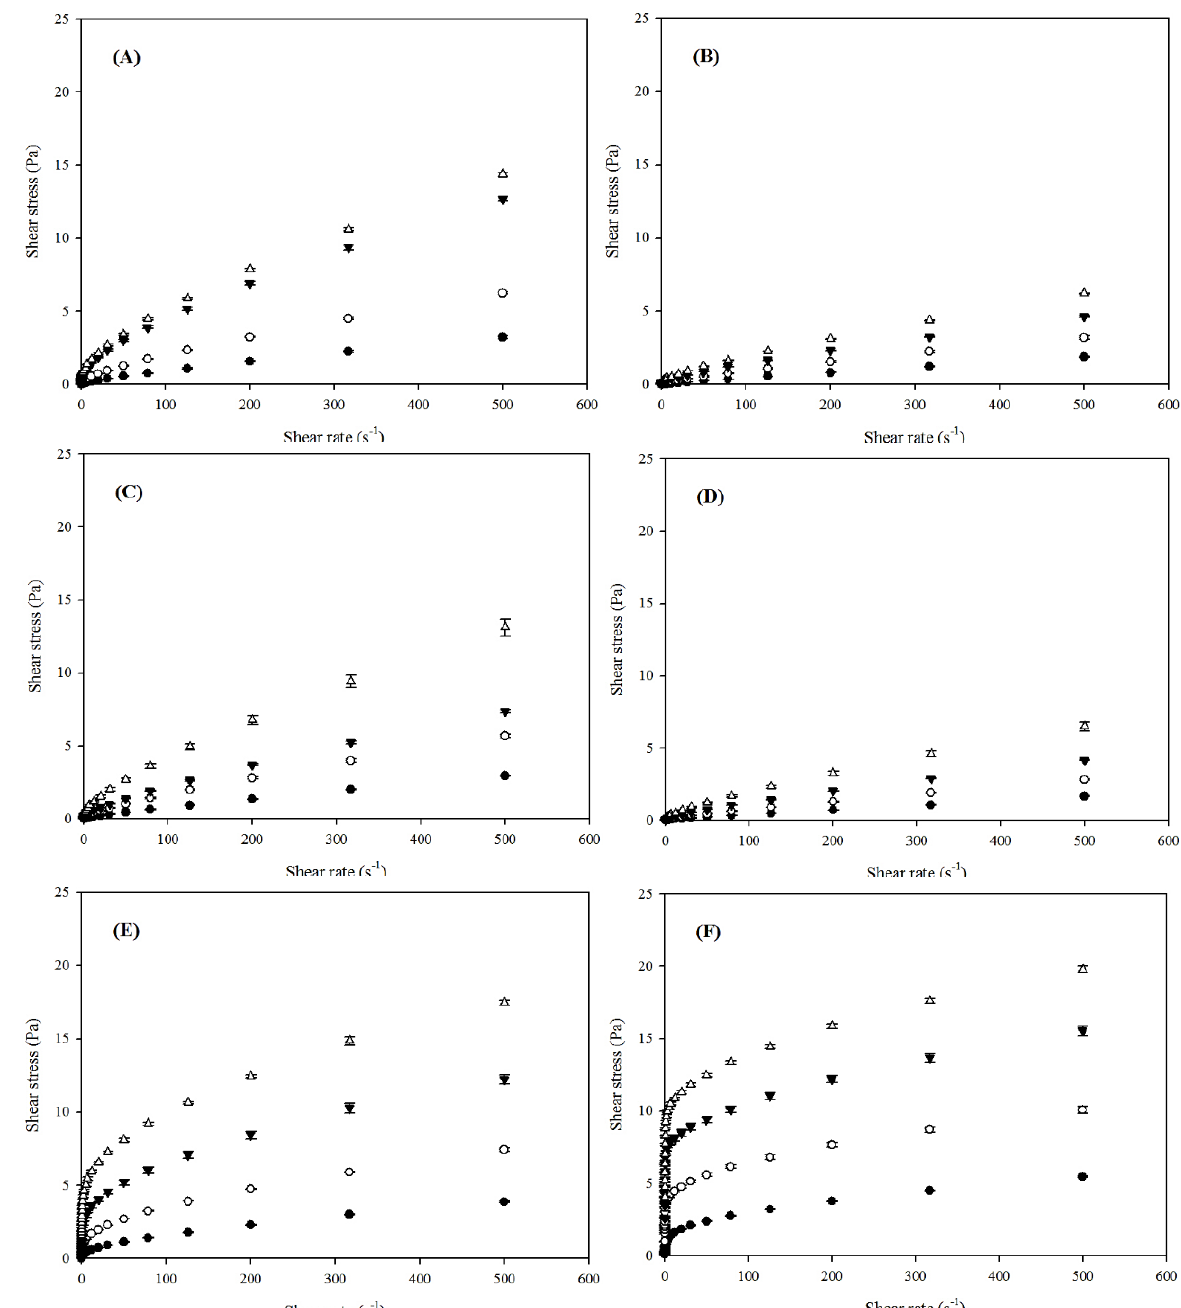
Figure 7. Shear stress as a function of shear rate for different concentrations of xanthan gum and chia seed mucilage extracted by ultrasound in combination with heat. ( A ) Heat/Ultrasound-50 °C/30 min; ( B ) Heat/Ultrasound-50 °C/60 min; ( C ) Heat/Ultrasound-80 °C/30 min; ( D ) Heat/Ultrasound- 80 °C/60 min; ( E ) Heat/Ultrasound-50 °C/60 min with purification; ( F ) xanthan gum. Error bars rep- resent standard deviations ( ● 0.25%, ○ 0.5%, ▼ 0.75%, 1%). The apparent viscosity of xanthan gum and chia seed mucilages extracted by ultra- sound in combination with heat at various concentrations are plotted in Figure 8 as a function of shear rate. The apparent viscosity of mucilage samples and xanthan gum de- creased as the shear rate increased, indicating their shear-thinning behavior, except for the unpurified mucilage samples at a concentration of 0.25%. Capitani et al. [13] mentioned